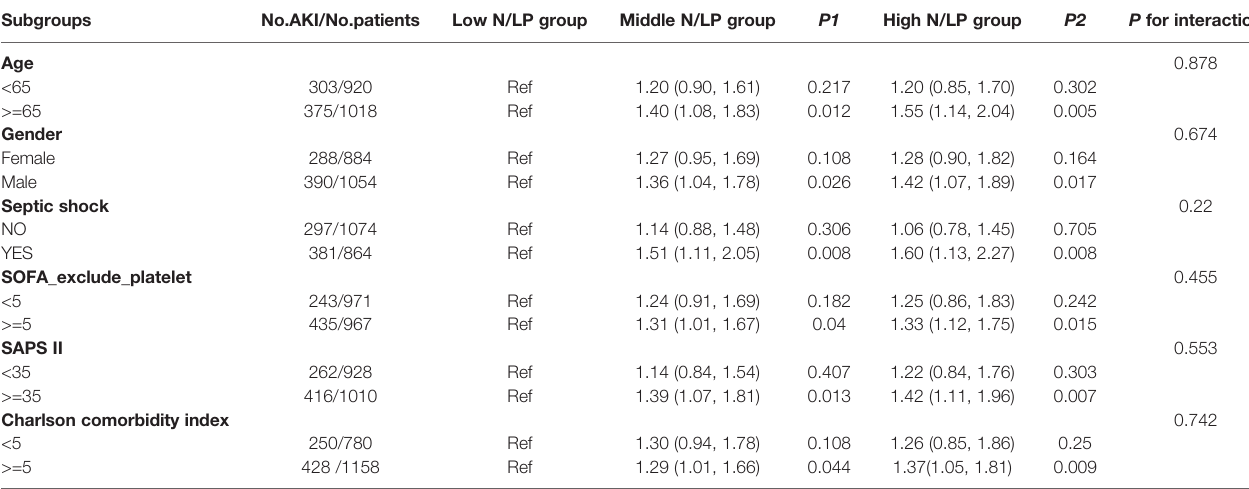
P1: Middle N/LP group vs Low N/LP group; P2: High N/LP group vs Low N/LP group; S-AKI, Sepsis associated acute kidney injury; N/LP, Neutrophil-to-Lymphocyte Platelet; SOFA, Sequential Organ Failure Assessment; SAPS II, Simpli fi ed acute physiology